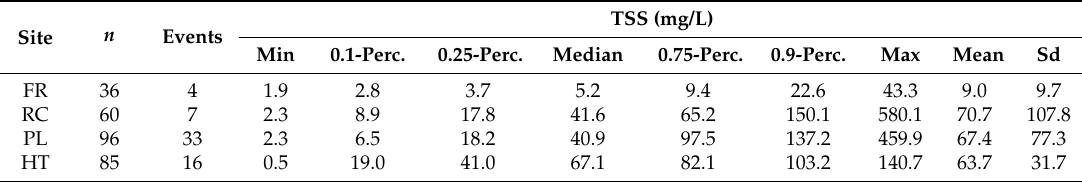
Table 2. Site-specific TSS sample statistics of samples used for turbidity correlation.